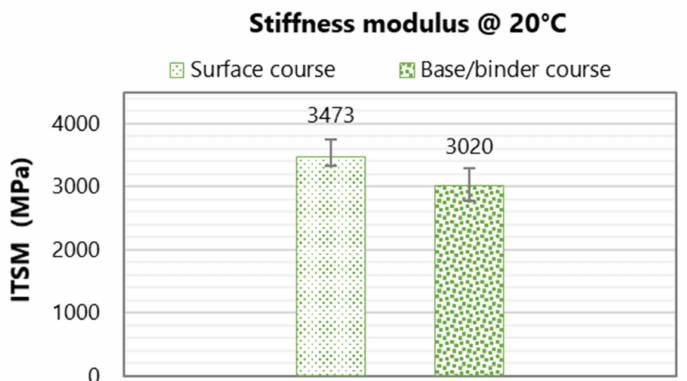
Figure 7. The indirect tensile modulus of cores after 1 year being in service.